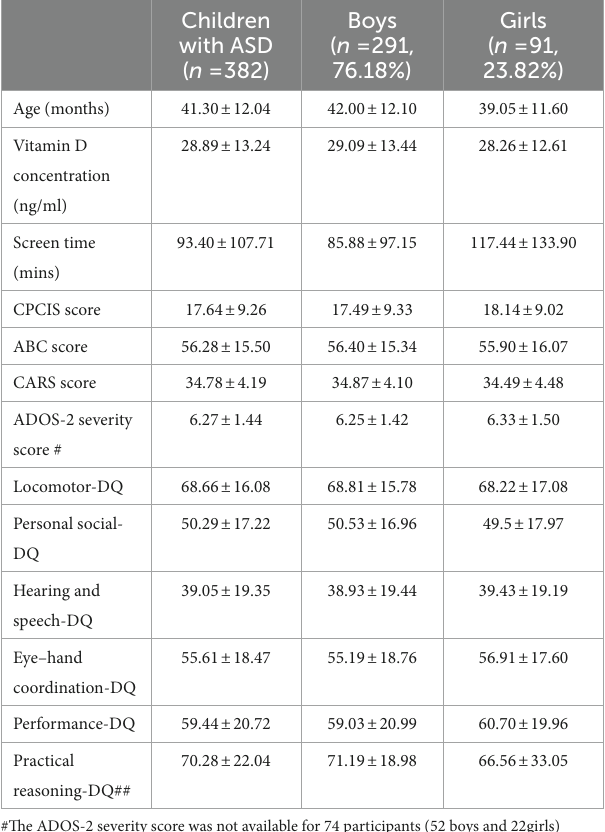
TABLE 1 Baseline characteristics of